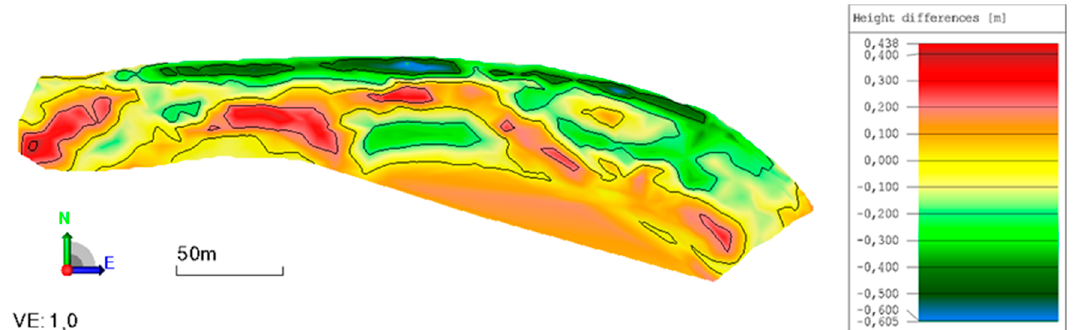
Figure 6. Height di ff erences between DTMs created on the basis of data acquired by the geodetic Figure 6. Height differences between DTMs created on the basis of data acquired by the geodetic method in 2016 and 2018. method in 2016 and 2018.